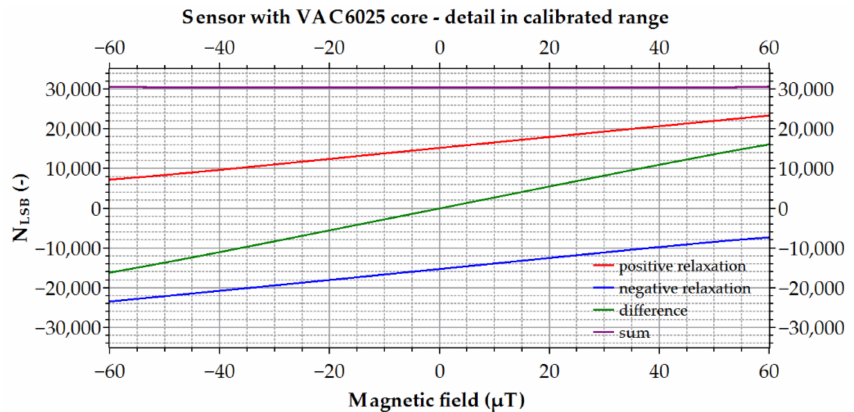
Figure 8. Block diagram of the measurement chain of one